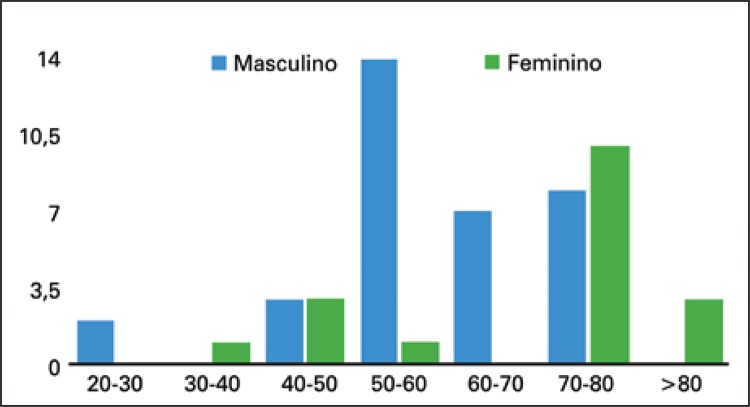
Distribuição dos pacientes por idade